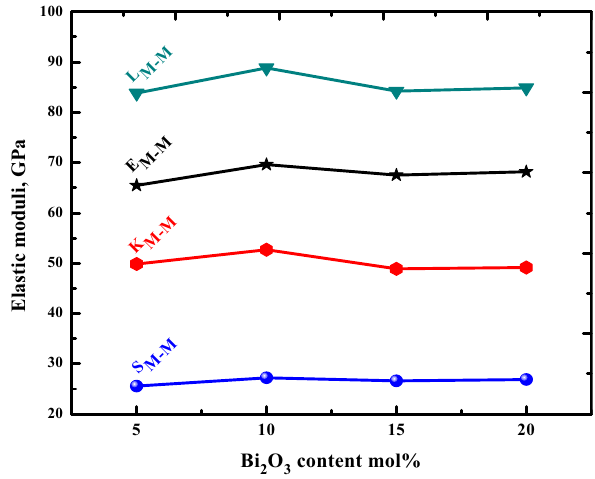
Figure 3: Variation of elastic moduli as a function of Bi 2 O 3 content mol% for all S1 – S4 glasses.